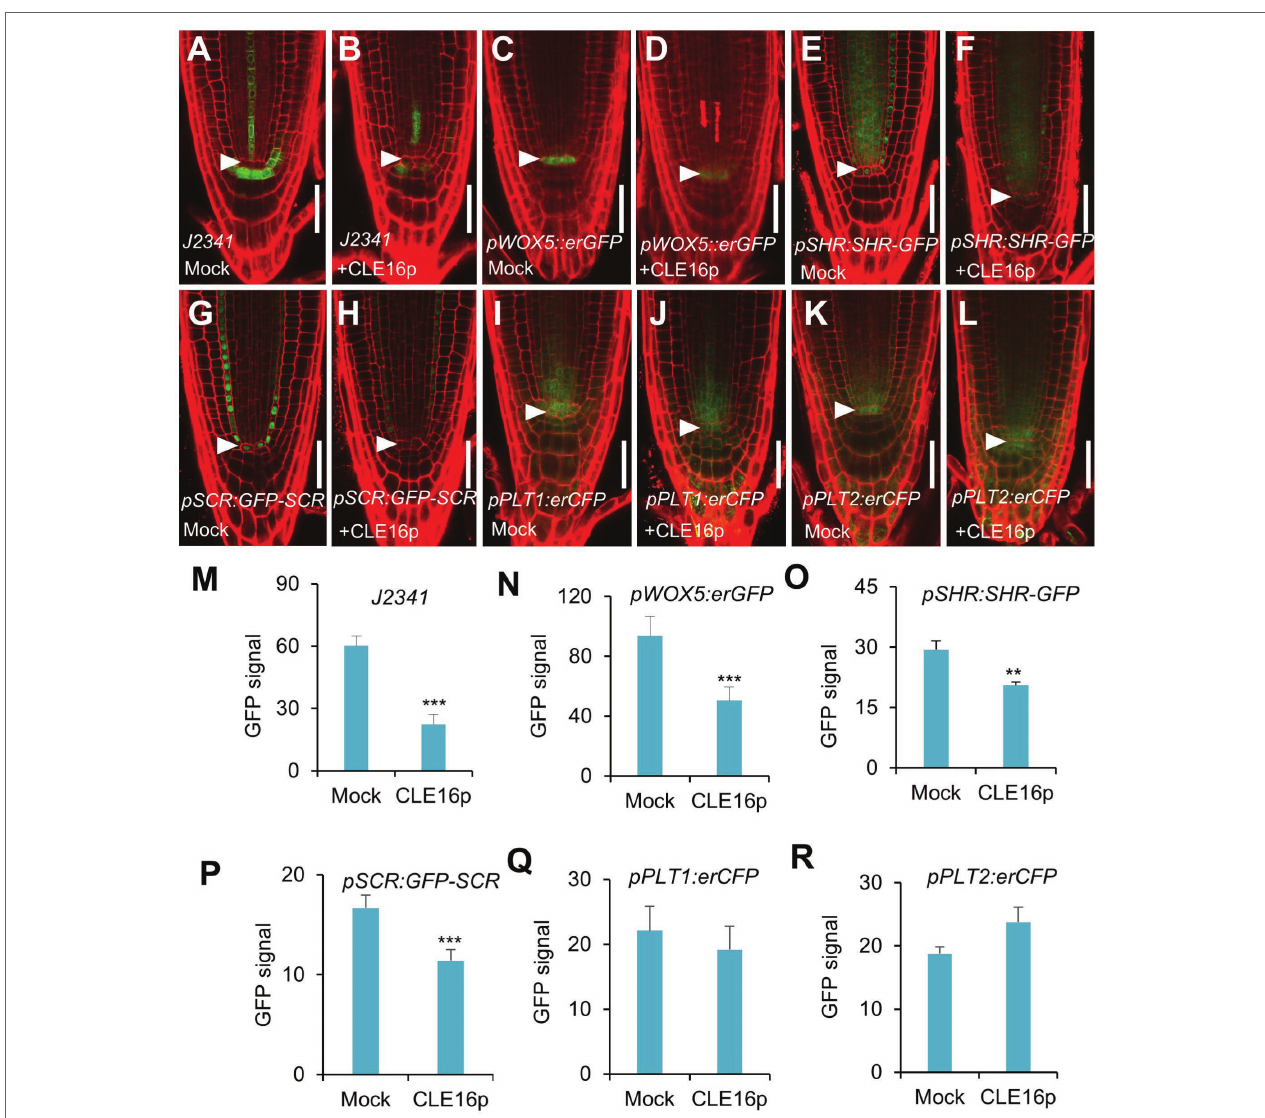
FIGURE 3 | Expression analysis of stem cell identity markers in roots with no peptide (Mock) or with CLE16p treatments. (A–L) Confocal images showing the representative expression patterns of J2341 in mock control (A) and CLE16p treatments (B) , pWOX5:erGFP in mock control (C) and CLE16p treatments (D) , pSHR:SHR-GFP in mock control (E) and CLE16p treatments (F) , pSCR:GFP-SCR in mock control (G) and CLE16p treatments (H) , pPLT1:erCFP in mock control (I) and CLE16p treatments (J) and pPLT2:erCFP in mock control (K) , and CLE16p treatments (L) . Roots were grown on agar medium supplemented with or without 1 μ M CLE16p for 5 days. Arrowheads indicate the QC cells. Scale bars represent 50 μ m. (M–R) Quantification of GFP signals in (A–L) . Error bars represent SD ( n = 10 for each genotype). Student’s t -test, * p < 0.05, ** p < 0.01, and *** p <